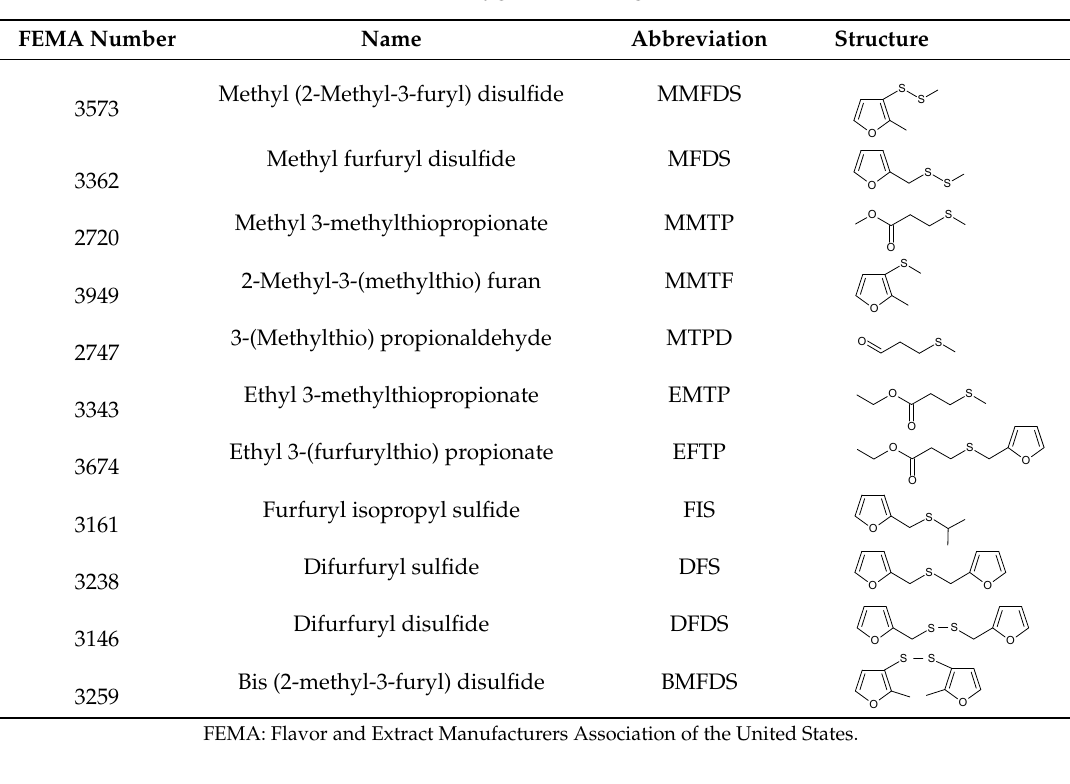
Table 1. Structure of eleven oxygen-containing sulfur flavor molecules.